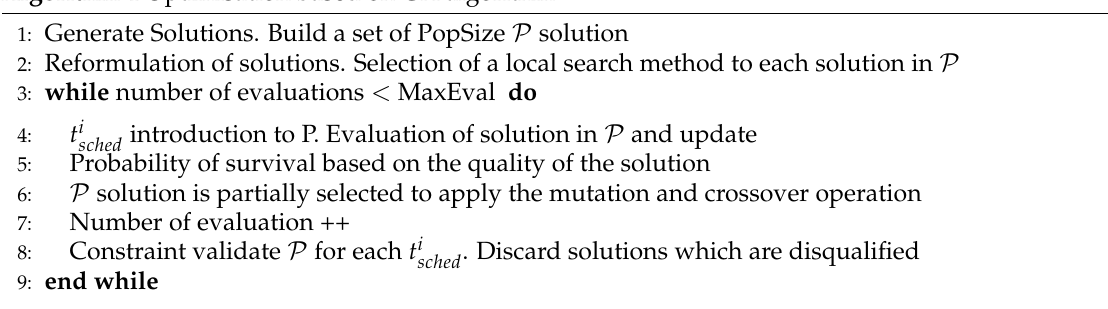
Algorithm 4 Optimisation based on GA algorithm